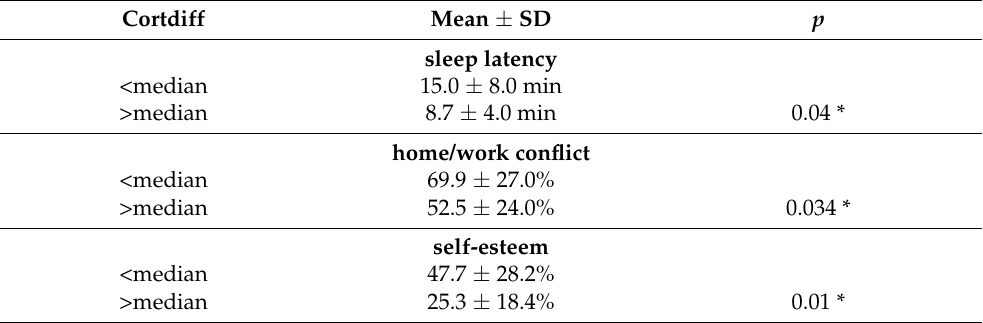
Table 5. Association of Cortdiff levels with sleep latency, the PSS subclasses home–work conflict and